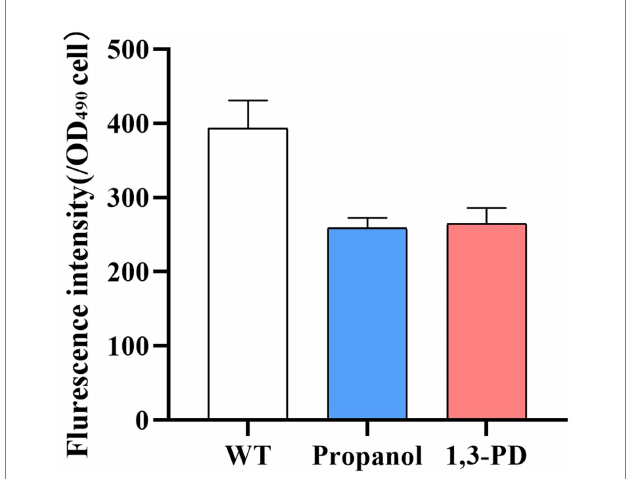
FIGURE 3 Analysis of ROS level under 6.0 g/L of propanol or 40.0 g/L of 1,3-PD.